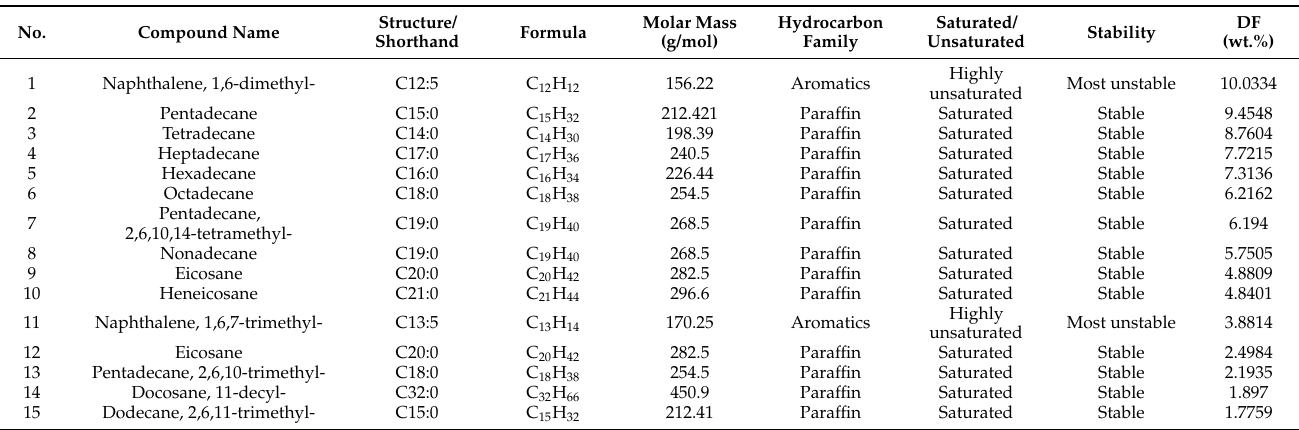
Table A1. Chemical composition of diesel